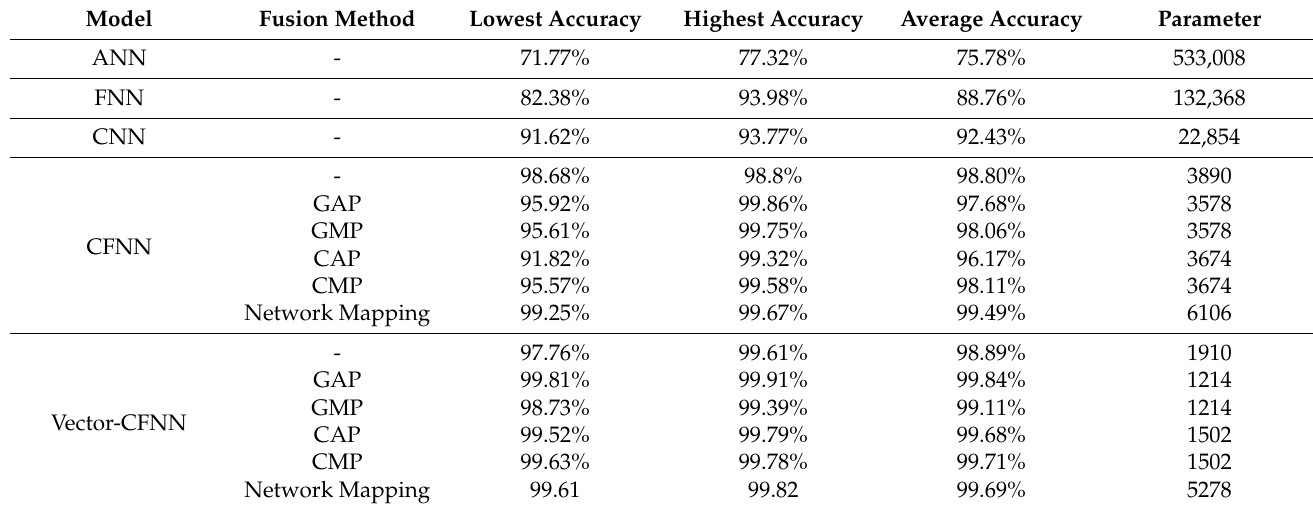
Table 3. Accuracy of fault diagnosis and parameters used in each